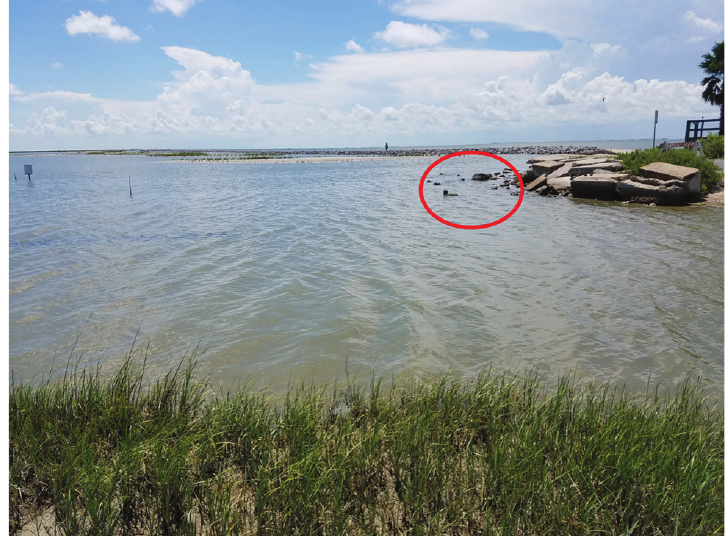
Figure 3. A view of the Sportsman Road site. The circled area indicates where anemones were sampled from in this study; anemones have also previously been located on the jetty in the background (Wicksten, pers. obs.). Taxonomic review of Diadumene